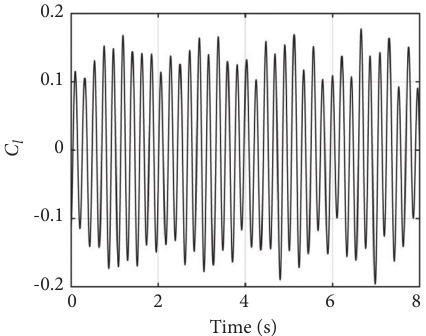
Figure 4: Time history of lift coefficient.